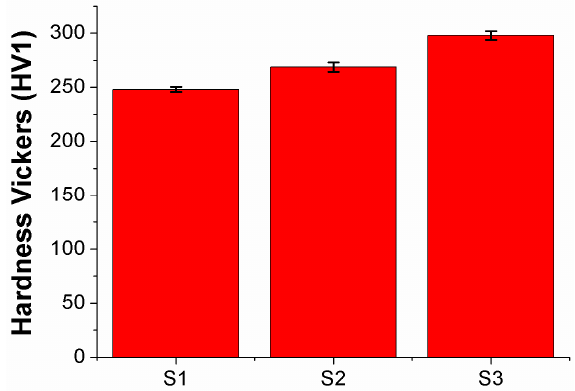
Figure 3. Macrohardness Vickers values for all the samples of study (S1, S2 and S3).